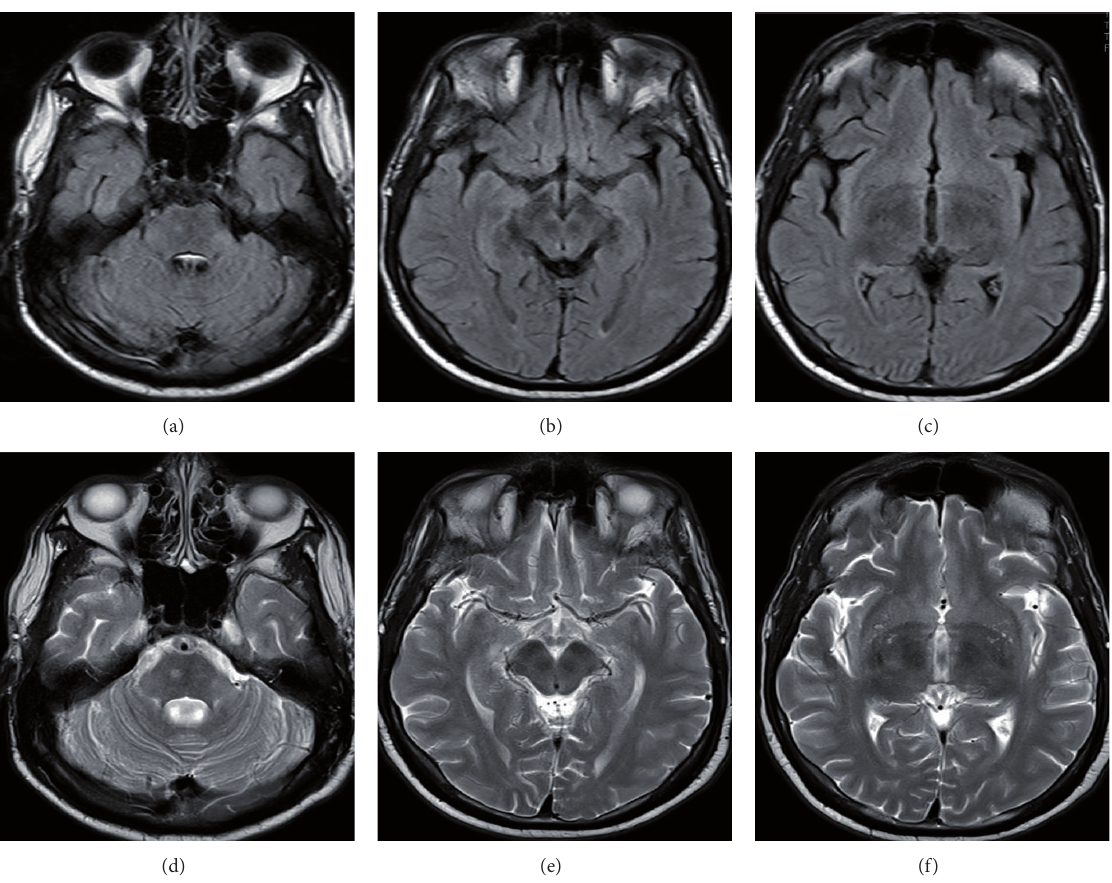
Figure 5: Follow-up non-contrast MRI after 2 months showing almost total resolution of the brain stem previous bright signal in FLAIR axial ((a)–(c)) and T2WI ((d)–(f)) images apart from tiny residual bright spot on right side of the